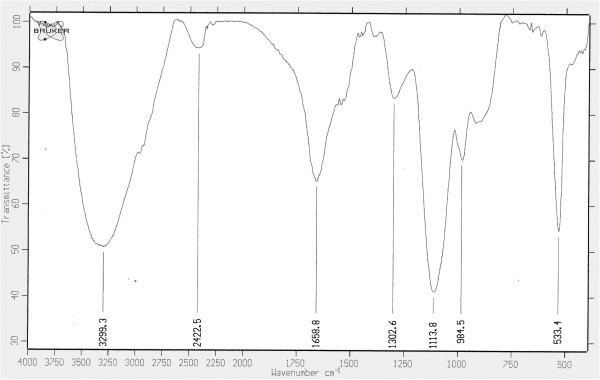
FTIR spectra of gold nanoparticles synthesized by the reduction of HAuCl4 by ID17.